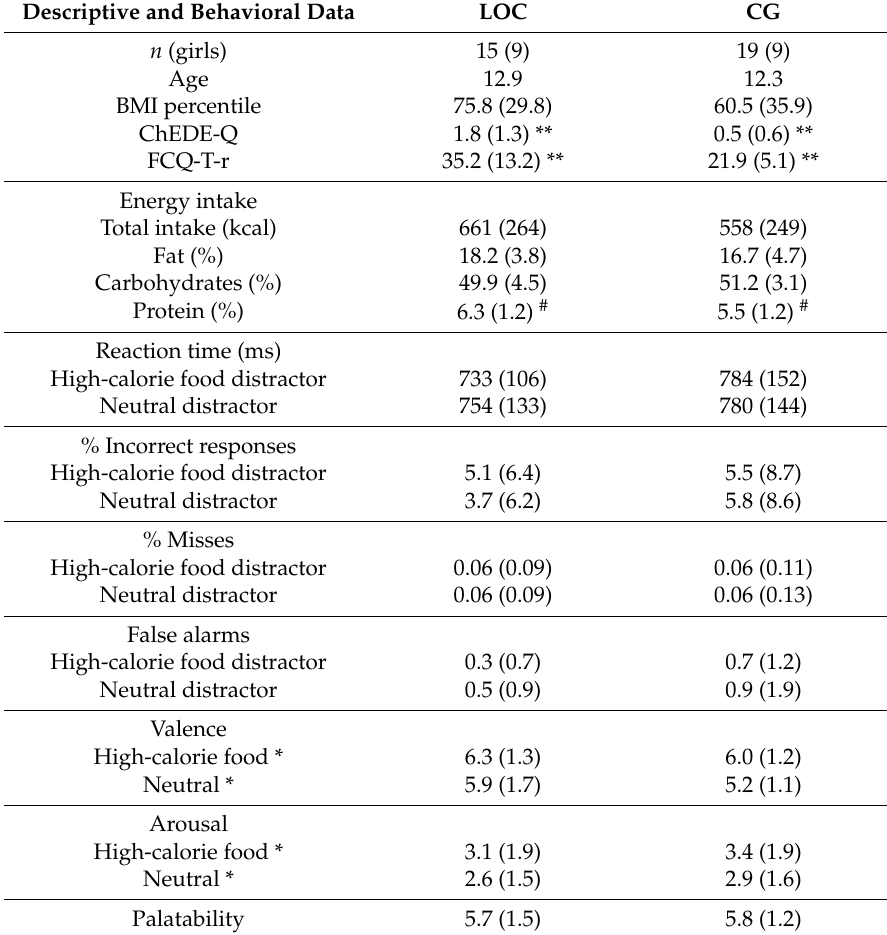
Table 1. Descriptive and behavioral data for the group with loss of control eating (LOC) and the matched control group